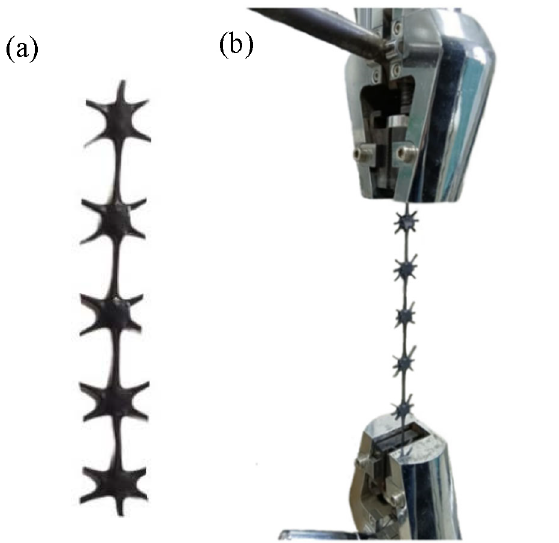
Figure 7. Test method for the mechanical properties of single rib method. ( a ) Selection of samples, ( b ) clamping